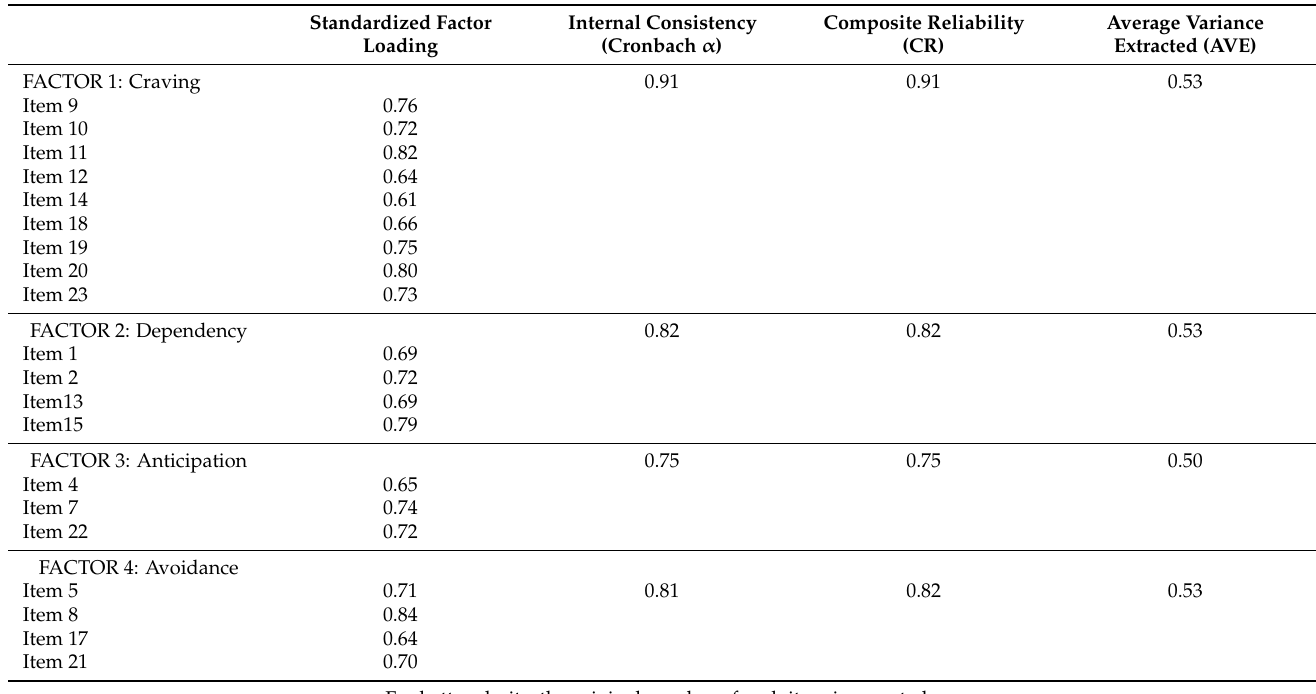
Table 4. The estimated four-factor model of the